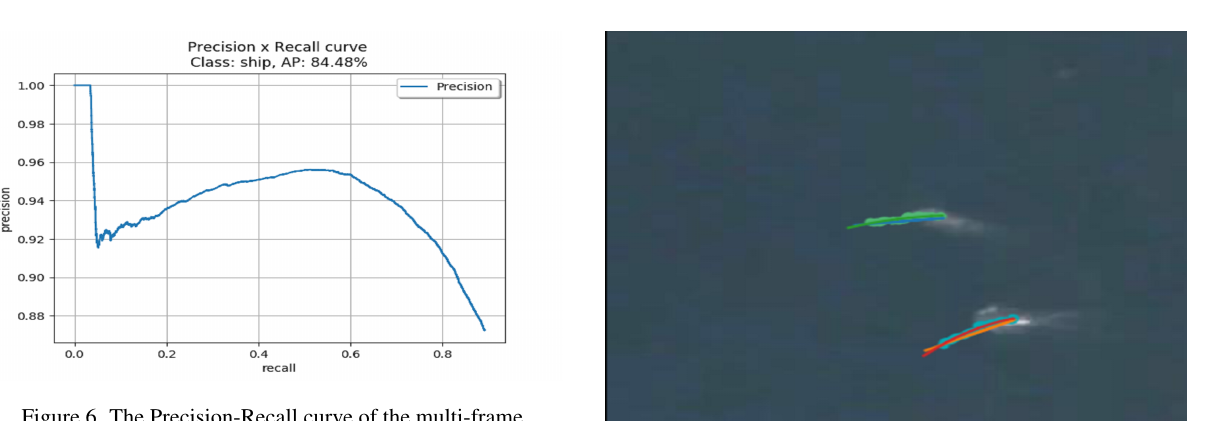
Figure 5. Visualization of ship detection results. The left image is obtained by the single frame YOLO v3 model, while the right one is from the multi-frame YOLO v3 model.